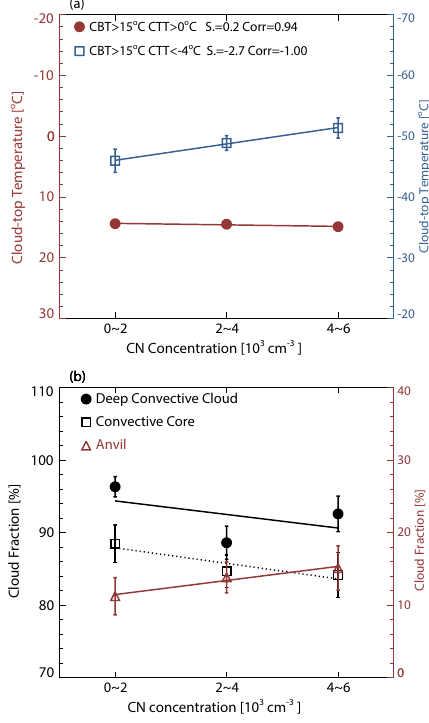
Figure 1. (a) Cloud-top temperature and (b) cloud fraction as a function of aerosol CN